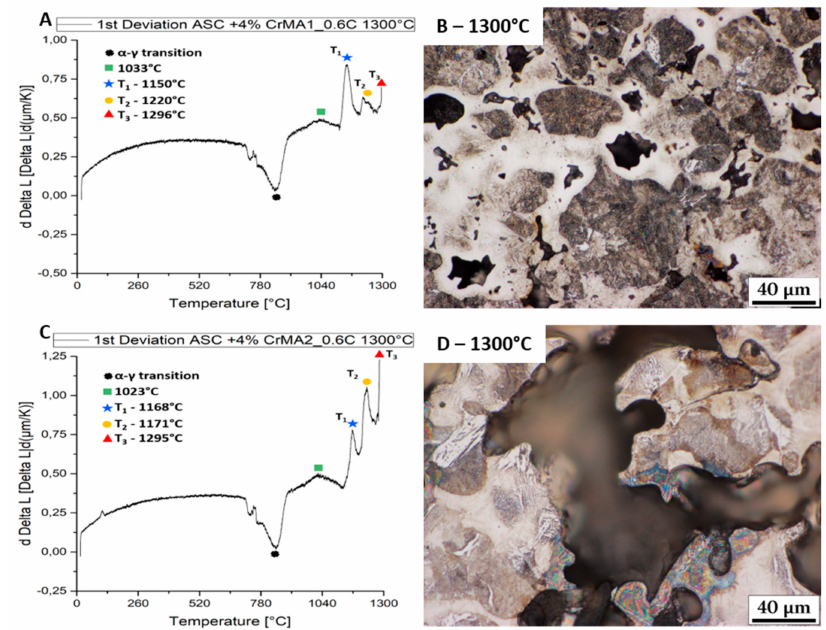
Figure 4. ( A , B ): Fast heating experiment (120 K/s) with ASC + 4% CrMA1_0.6C nom (0.6C comb ), ( A ) 1st Dev of the dilatometer (heating segment), ( B ) Sample quenched from 1300 ◦ C; ( C , D ): Fast heating experiment (120 K/s) with ASC + 4% CrMA2_0.6C nom (0.59C comb ), ( C ) 1st Dev of the dilatometer (heating segment), ( D ) Sample quenched from 1300 ◦